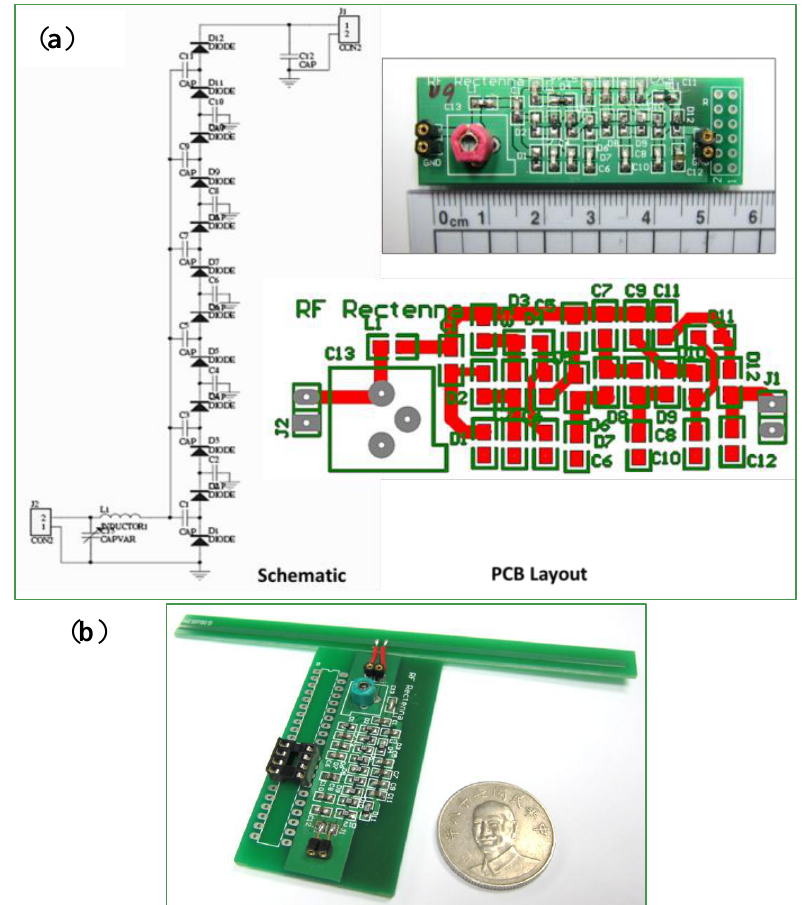
multi-stage rectifier: ( a ) Schematic view of circuit diagram, PCB layout and trial-fabricated sample. ( b ) Completed